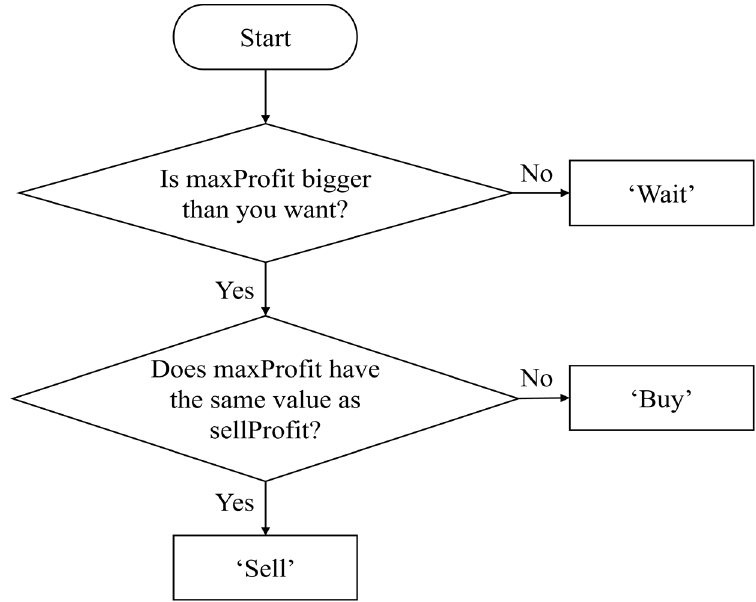
Figure 5. Flowchart of the class definition.